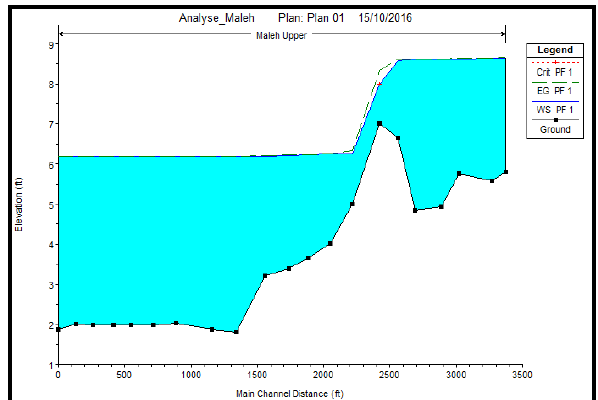
Figure 5. Extract of the Digital Flood Model